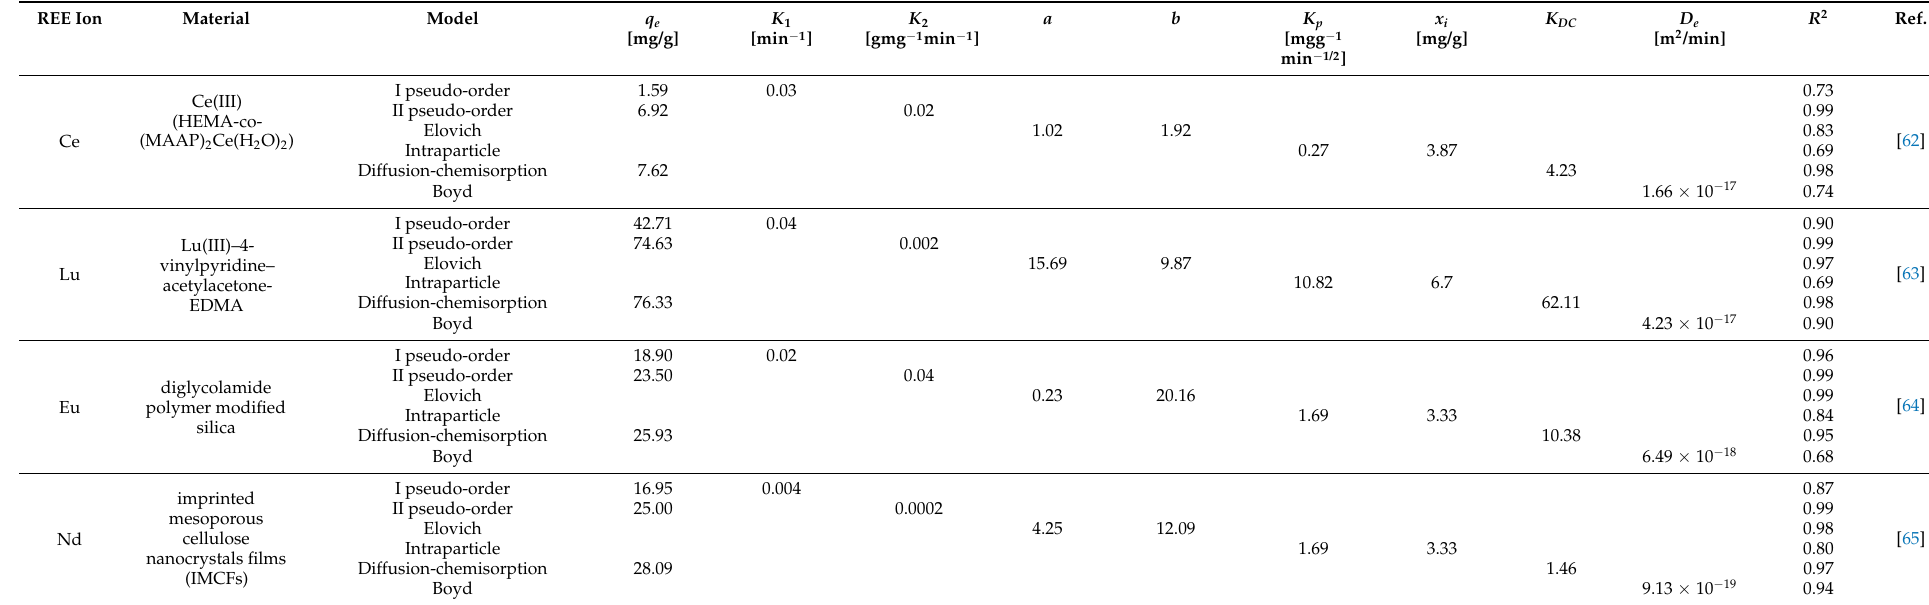
Table 1. Comparison of simulation results for various REE ions obtained in REE 1.0